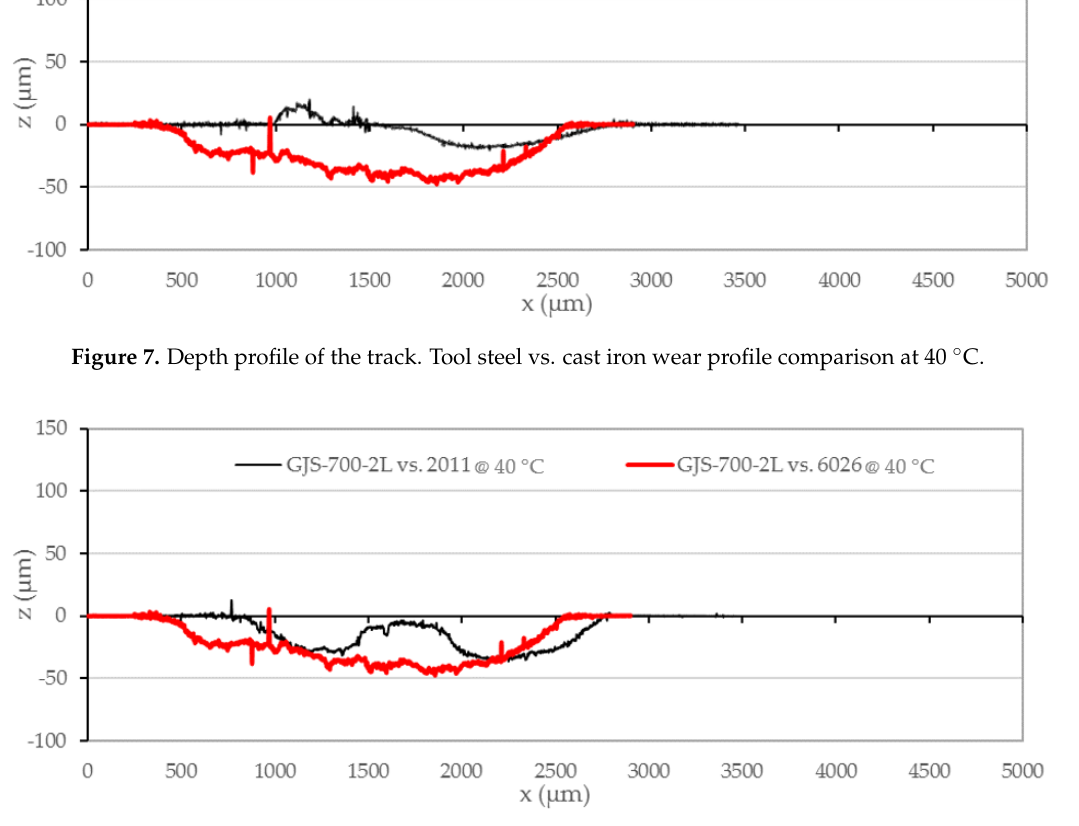
Figure 7. Depth profile of the track. Tool steel vs. cast iron wear profile comparison at 40 °C.